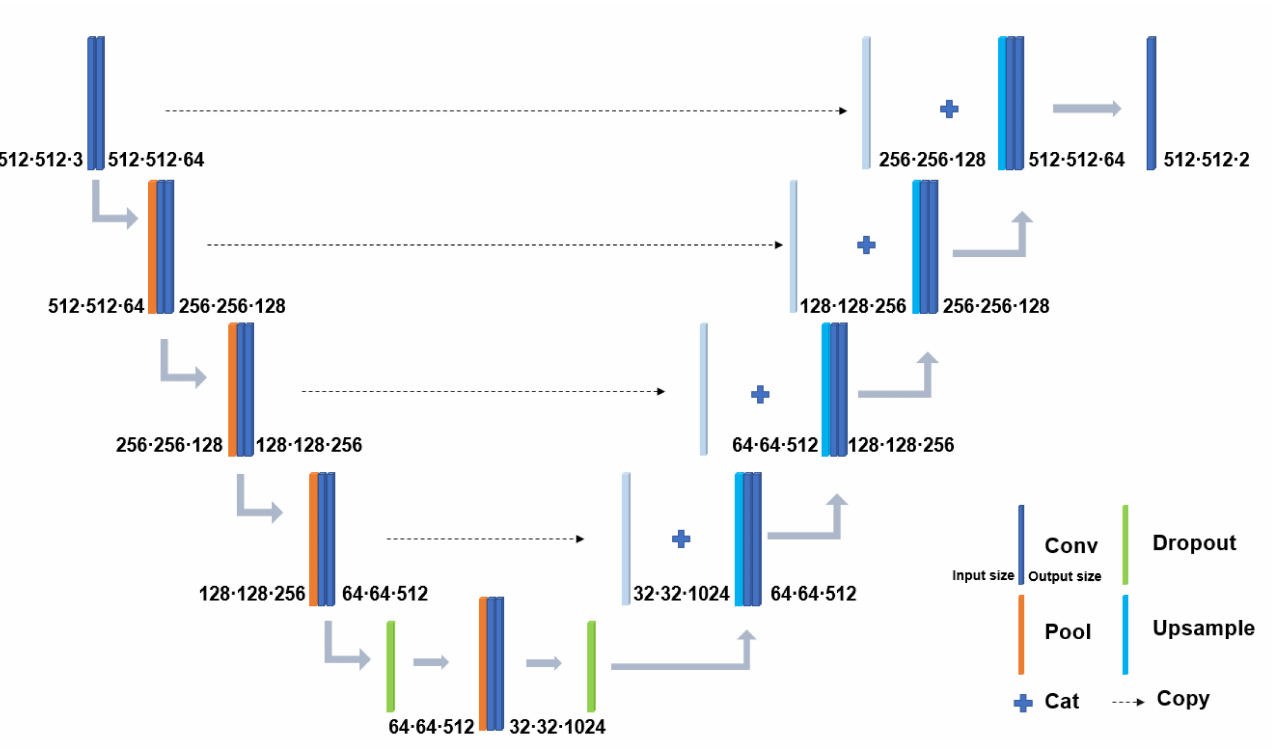
Figure 3. The U-Net architecture used in this